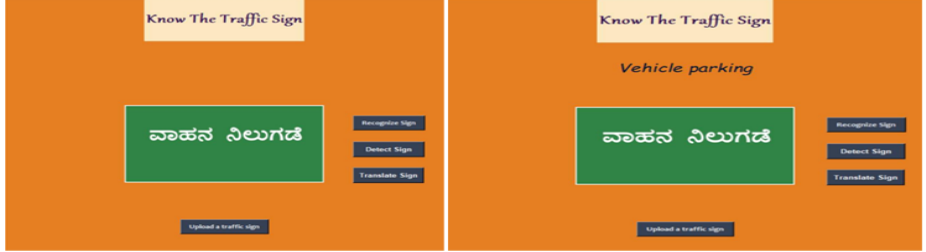
Fig. 14. showing results for applied input image.